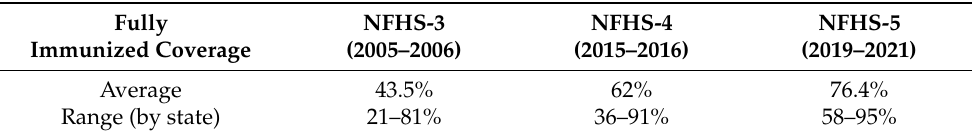
Figure 1. Percent of Fully Immunized Children (National Family Health Surveys—NFHS). Table 1. India fully immunized coverage (12–23-month-olds, card and maternal recall) by state from National Family Health Surveys.